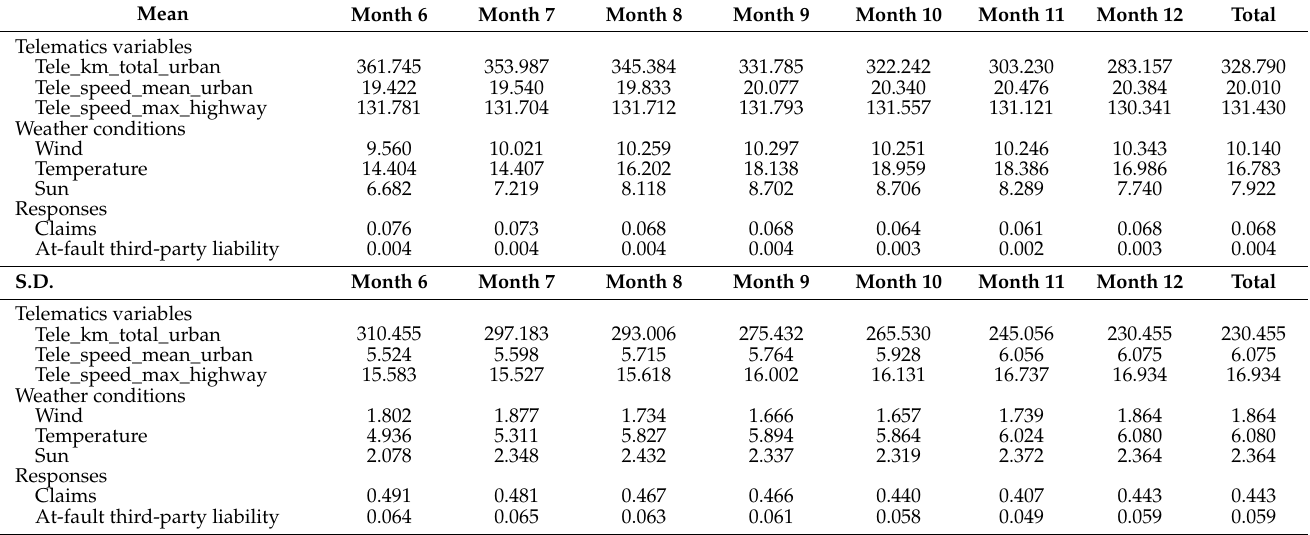
Table A1. Descriptive statistics: mean and standard deviation (SD) for 20,784 policyholders in seven observed months in 2018 and